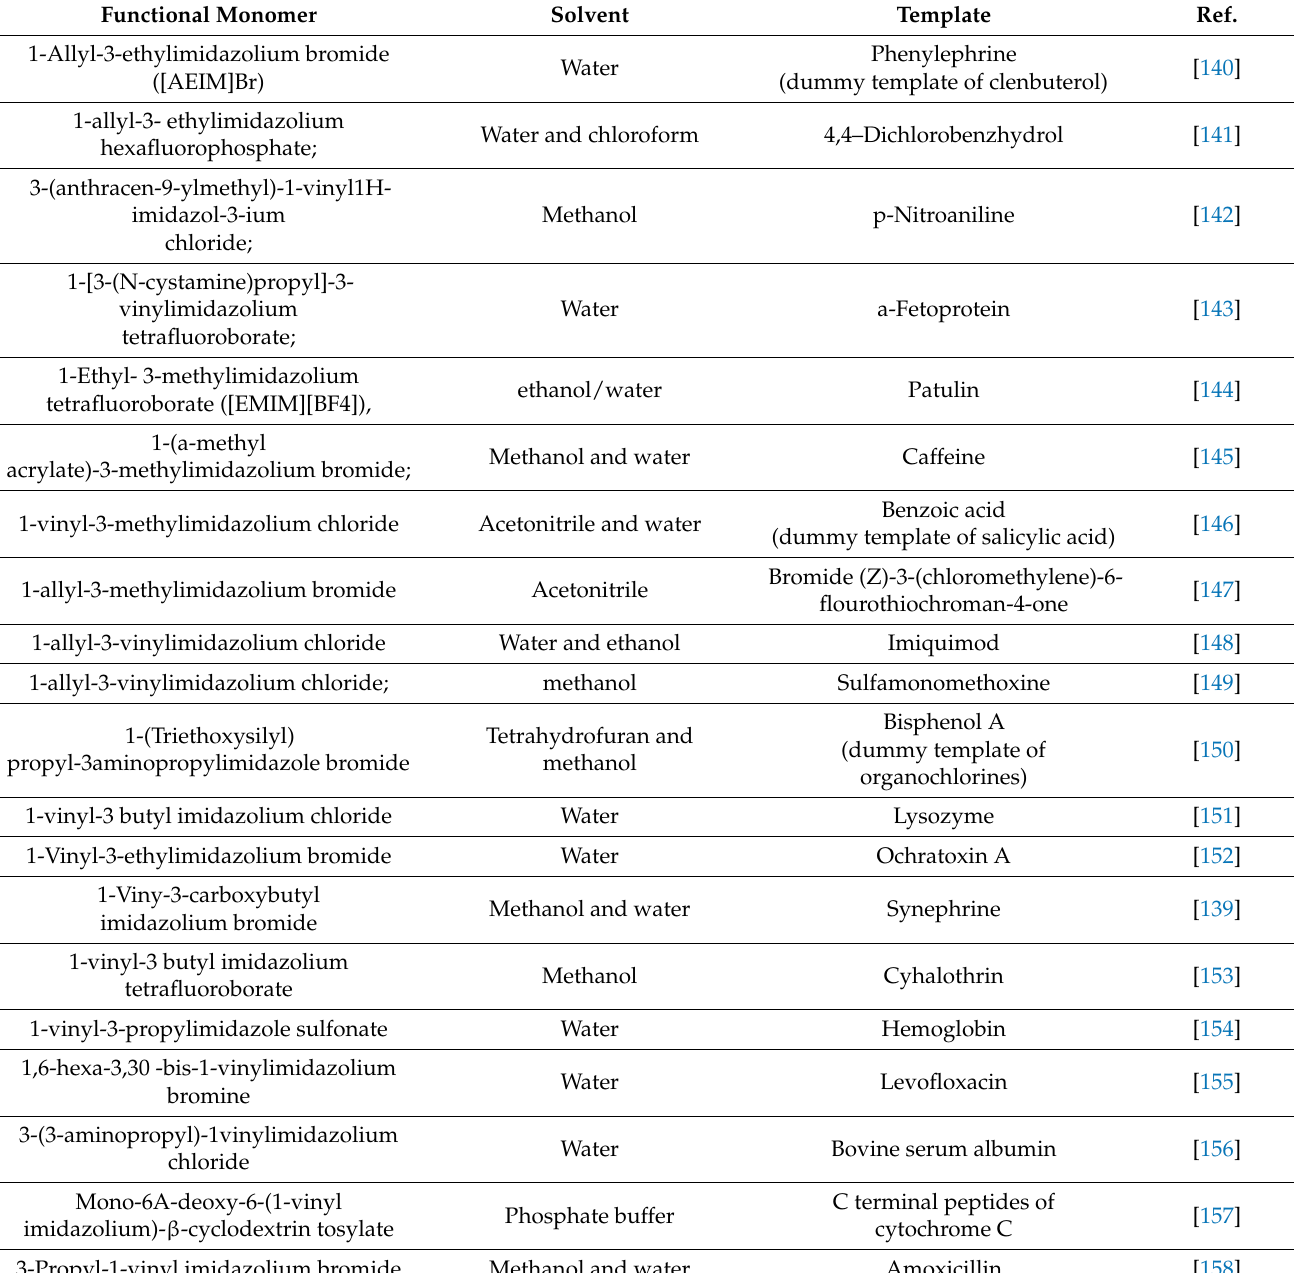
Table 1. Some examples of ionic liquids used as functional monomers in the synthesis of im- printed